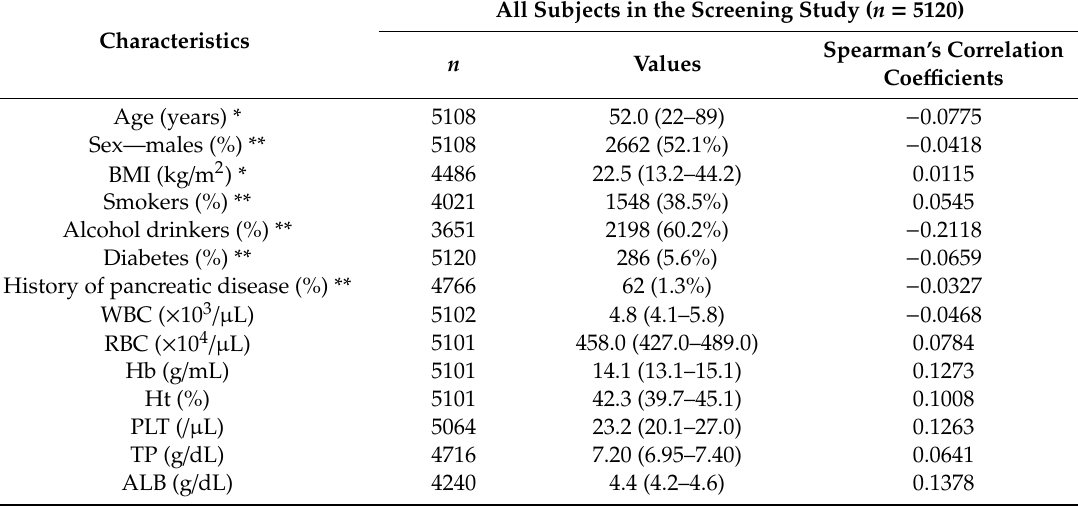
Table 1. Background characteristics of all subjects in the screening